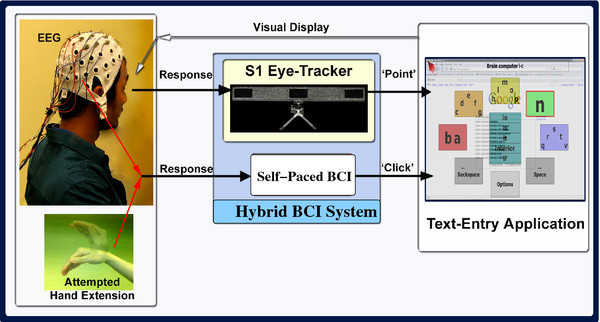
Our Hybrid BCI System. The hybrid BCI system proposed in
[7].